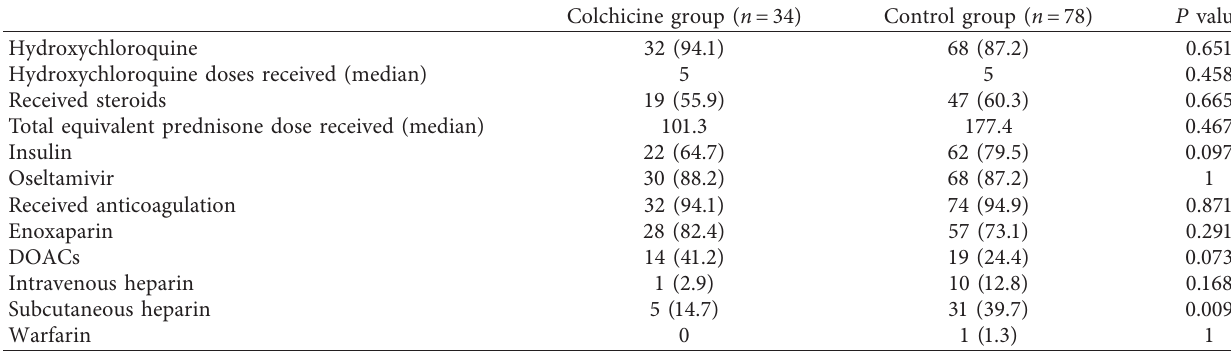
Table 3: Comparison of medications received during the hospitalization across the comprehensive analysis colchicine and control groups. Hydroxychloroquine doses received and total equivalent prednisone dose received were nonnormally distributed. The Mann–Whitney U test was used to compare the two groups. The χ 2 test was used to check for differences in the number of patients receiving steroids, insulin, anticoagulation, enoxaparin, subcutaneous heparin, and direct acting oral anticoagulants (DOACs). Fisher’s exact test to check for dif- ferences in the number of patients receiving hydroxychloroquine, oseltamivir, intravenous heparin, and